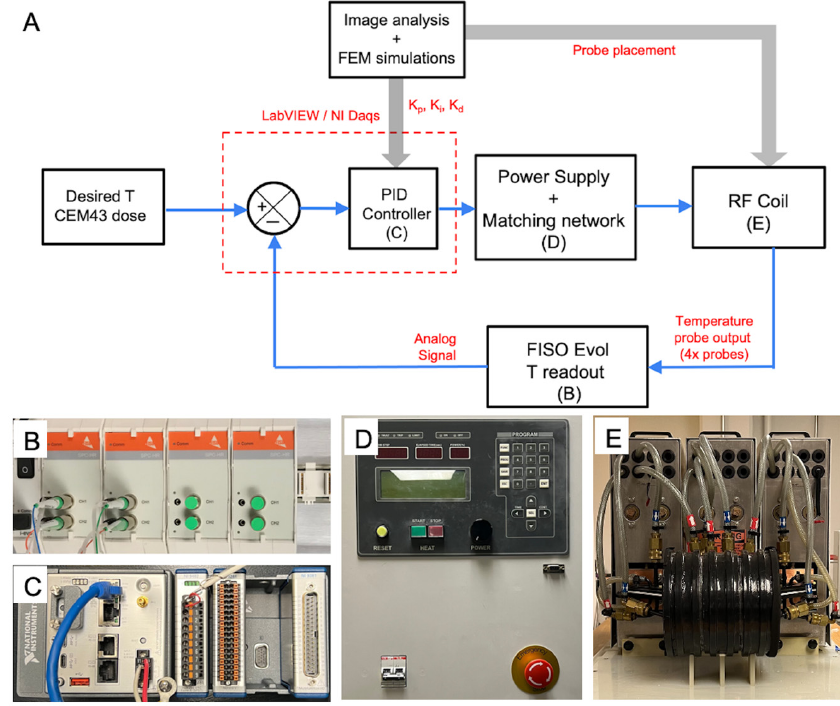
Figure 1. Experimental setup for temperature feedback control in magnetic hyperthermia (MHT) of canine glioblastoma. ( A ) Schematic block diagram depicting the core components, the flow of input, output signals and generation of control signals during feedback control of temperature during MHT. Core components include the (i) multi-sensor FISO EVO fiber optic probe for temperature measurement, (ii) FISO SPC-HR fiber optic reading module for conversion of temperature to analog outputs ( B ), (iii) a NI CompactRIO (NI cRIO 9042) controller with the multifunction I/O module and compatible LabVIEW software interface ( C ), (iv) 120 kW alternating magnetic field (AMF) induction heating power supply ( D ), and (v) a 20 cm diameter radiofrequency (RF) modified Maxwell coil applicator ( E ). User inputs to the LabVIEW interface include the setpoint temperature , 𝑇 (cid:3045)(cid:3032)(cid:3033) , safety threshold temperature per measurement sensor (e.g., 50 °C to prevent ablation and runaway at treatment zone), second safety temperature threshold to prevent burns from non-specific Joule heat- ing (e.g., 40 °C for probe placed at outer surface of brain), lower and upper voltage limits on the power supply for electrical safety, and proportional-integral-derivative (PID) controller gains. 2.2. Optical Fiber Thermometry and Multi-Sensor Probe Temperature measurements were performed using fiber optic temperature probes comprising four gallium arsenide (GaAs) temperature sensors spaced 2 cm apart along the length of a 0.8 mm diameter optical fiber (FISO Technologies, Ltd., Quebec, Canada). The manufacturer calibrated the probe. It provided readings with accuracy ±0.3 °C, reso- lution 0.1 °C, and response time <100 ms. A FISO EVO-RM-8 Rack-Mount (FISO Technol- ogies, Ltd.) signal generator, along with four FISO SPC-HR (FISO Technologies, Ltd.) modules, with analog output (AO) ports were used to read temperature signals from the fiber optic probes and transfer signals from the analog output ports to the controller. 2.3. Controller Design Our objective in this effort was to validate a temperature control device to automate MHT of spontaneous canine gliomas. Fully automated treatment to a prescribed plan re- quires real-time temperature feedback. Additional temperature monitoring at sites distant from target enabled with override function is also needed to minimize overtreatment out- side the target and to reduce risks of excessive power deposition from induced eddy cur- rent heating. A typical setup for controlling temperature during tissue heating or MHT